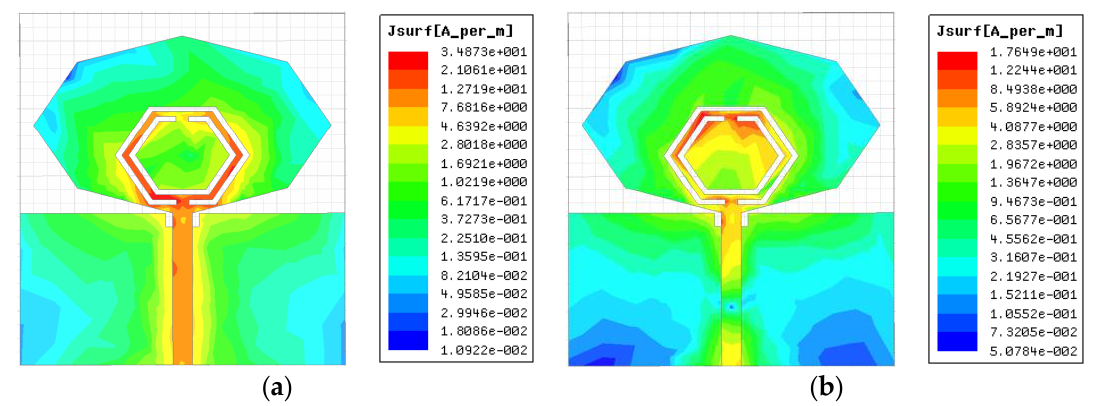
Figure 4. Surface current distributions at ( a ) 3.5 GHz; ( b ) 5.5 GHz.